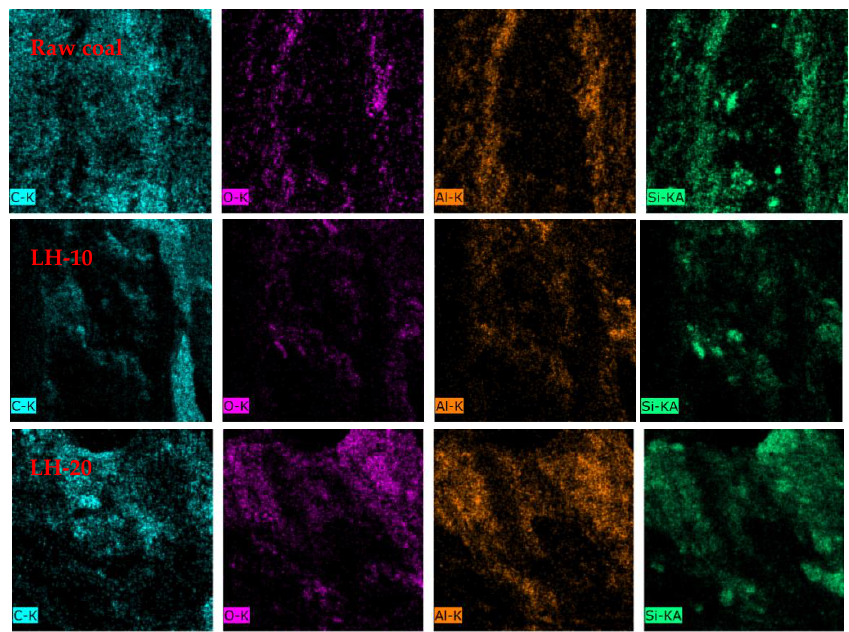
Figure 4. EDS plane sweep of the coal sample before and after heating oxidation at 200 °C.